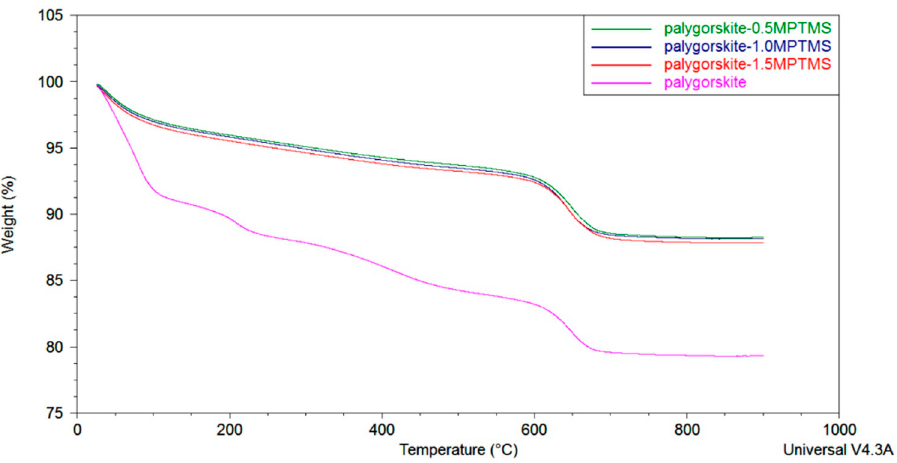
Figure 3. TGA diagrams of pure and functionalized by MPTMS palygorskite.